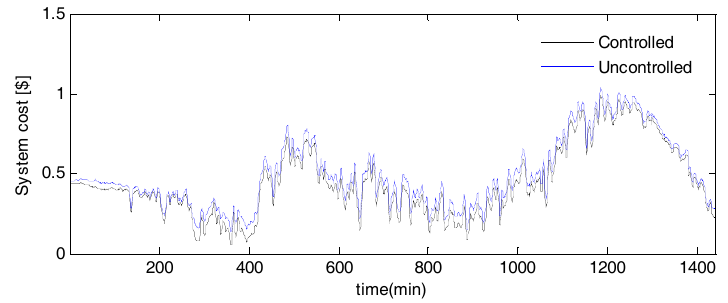
Figure 9. Total system cost for the controlled and uncontrolled cases.